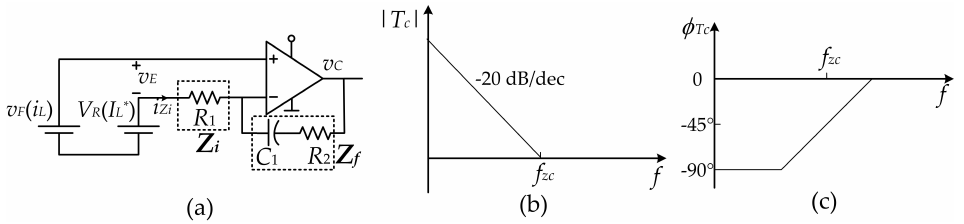
Figure 4. Proposed PI controller:( a ) analog implementation, ( b ) amplitude, and ( c ) phase of the ideal Bode